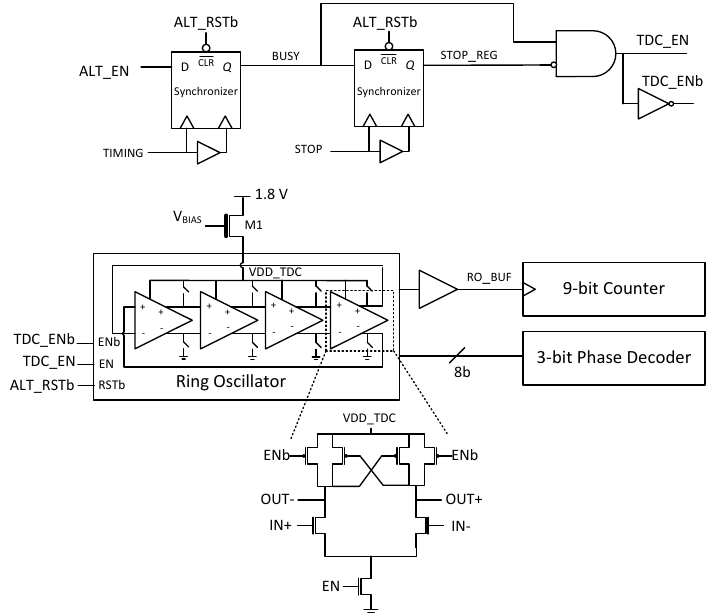
Figure 7. TDC schematic based on a four-stage differential ring oscillator.